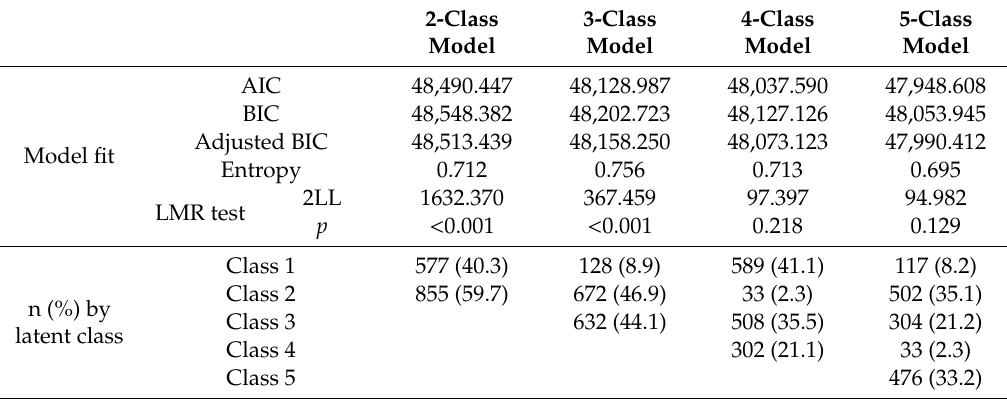
Table 3. Determining the number of latent classes according to the development trajectory of depressive symptoms (n = 1432).